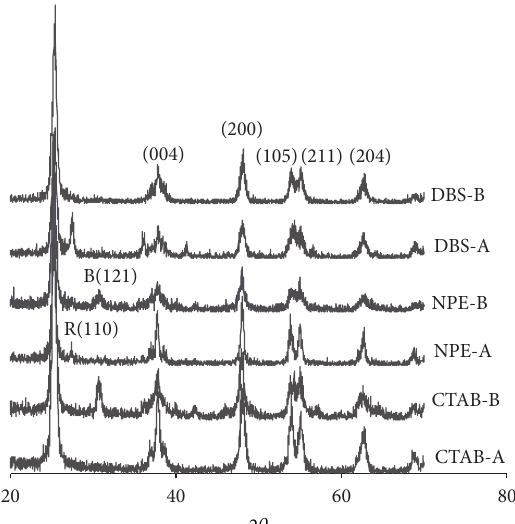
Figure 2: X-ray diffraction spectra for TiO 2 at different pH and